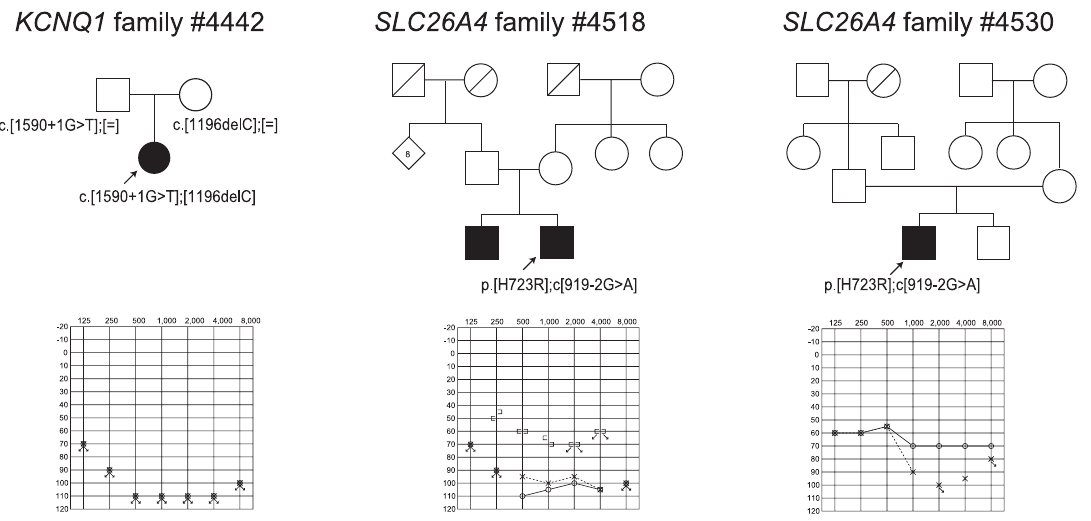
Figure 3. The pedigrees and audiograms of the patients with splice-site mutations after confirmation by Sanger sequencing.